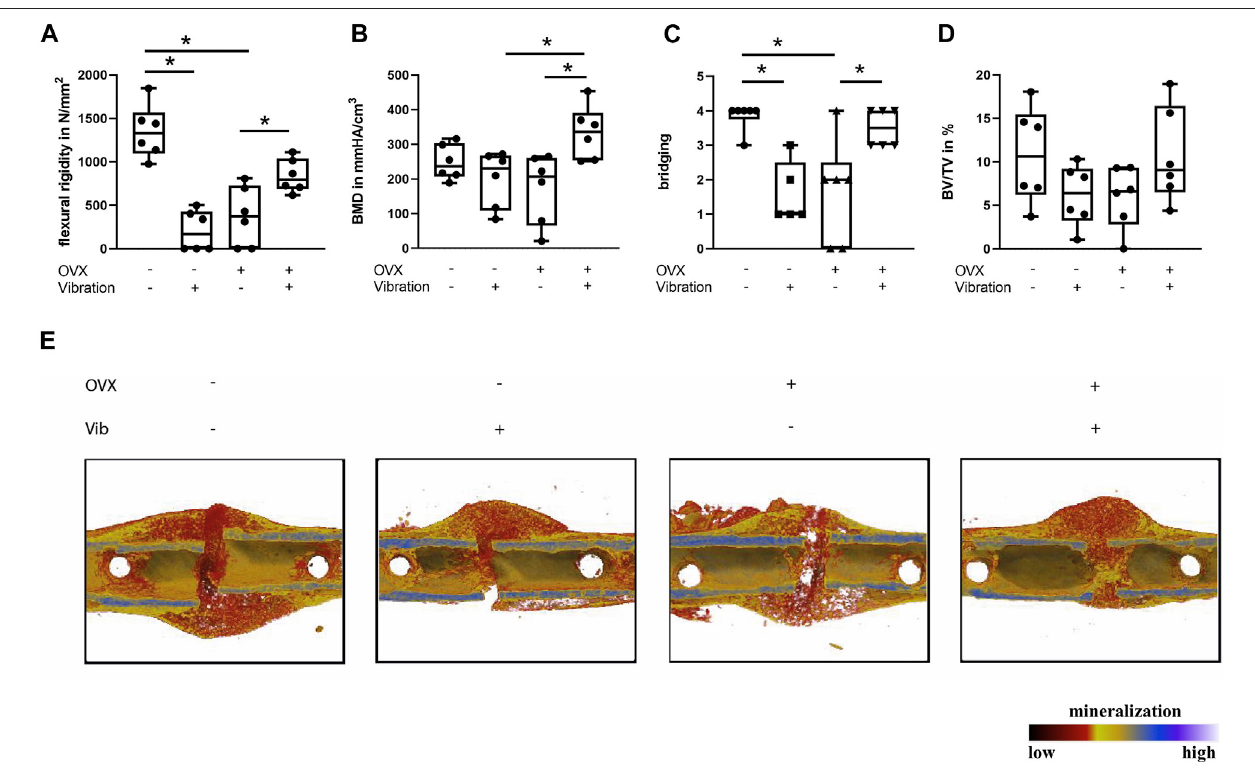
FIGURE 2 | In fl uence of LMHFV on fracture healing in ER α fl / fl mice on day 21. Biomechanical testing and μ CT analysis. (A) Bending stiffness of the fracture callus. (B) Bonemineraldensityofthefracturegap. (C) Bonybridgingofthefracturegapevaluatedintwoperpendicularplanes. (D) Relativebonevolume(BV/TV)inthefracture gap. (E) Representative μ CT images from the fractured femurs. Red indicates weakly mineralized bone, whereas yellow and light blue indicate highly mineralized bone. Data are shown as box-and-whisker plots (with median and interquartile range) from max. to min., showing all data points. *indicates signi fi cant effects with p ≤